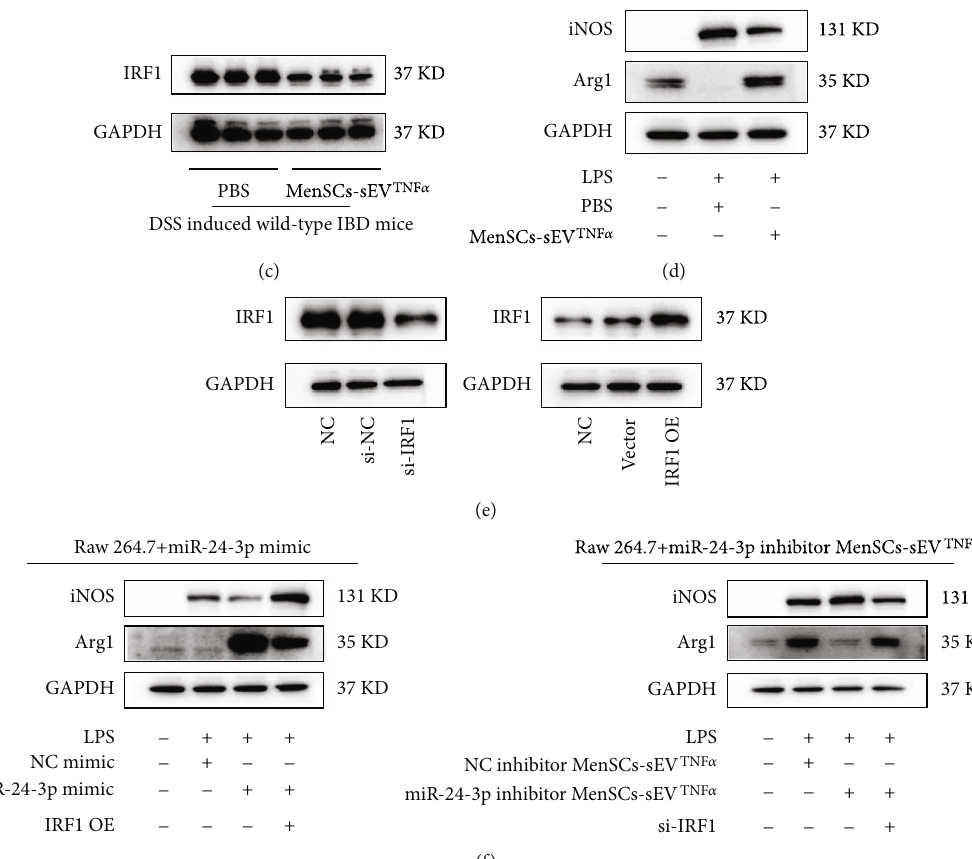
Figure 8: MenSCs-sEV TNF- α promotes the polarization of M2 macrophages through miR-24-3p and its downstream IRF1. (a) Luciferase reporter gene assay showed that miR-24-3p could bind to site 1 of IRF1. (b) Representative fl ow cytometry images showed the proportion of M1(F4/80+iNOS+) and M2(F4/80+CD206+) macrophages in RAW264.7 cells with di ff erent treatments. (c) The protein expression of IRF1 was presented by Western blotting after intraperitoneal injection of MenSCs-sEV TNF- α in DSS-induced acute IBD mice. (d) Western blotting images of RAW264.7 with three treatments, including control, LPS+PBS, and LPS+MenSCs-sEV TNF- α . (e) The e ff ects of si-IRF1 and IRF1 OE plasmid transfection on the expression of IRF1 in RAW264.7 were veri fi ed by Western blotting. (f) After processing RAW264.7 with LPS and knockdown or overexpression (OE) of miR-24-3p and IRF1, the Western blotting image of iNOS and Arg1 was